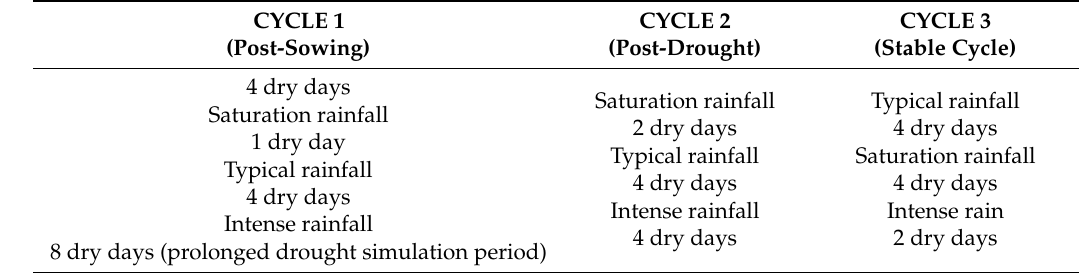
Table 3. Simulated precipitation cycles.